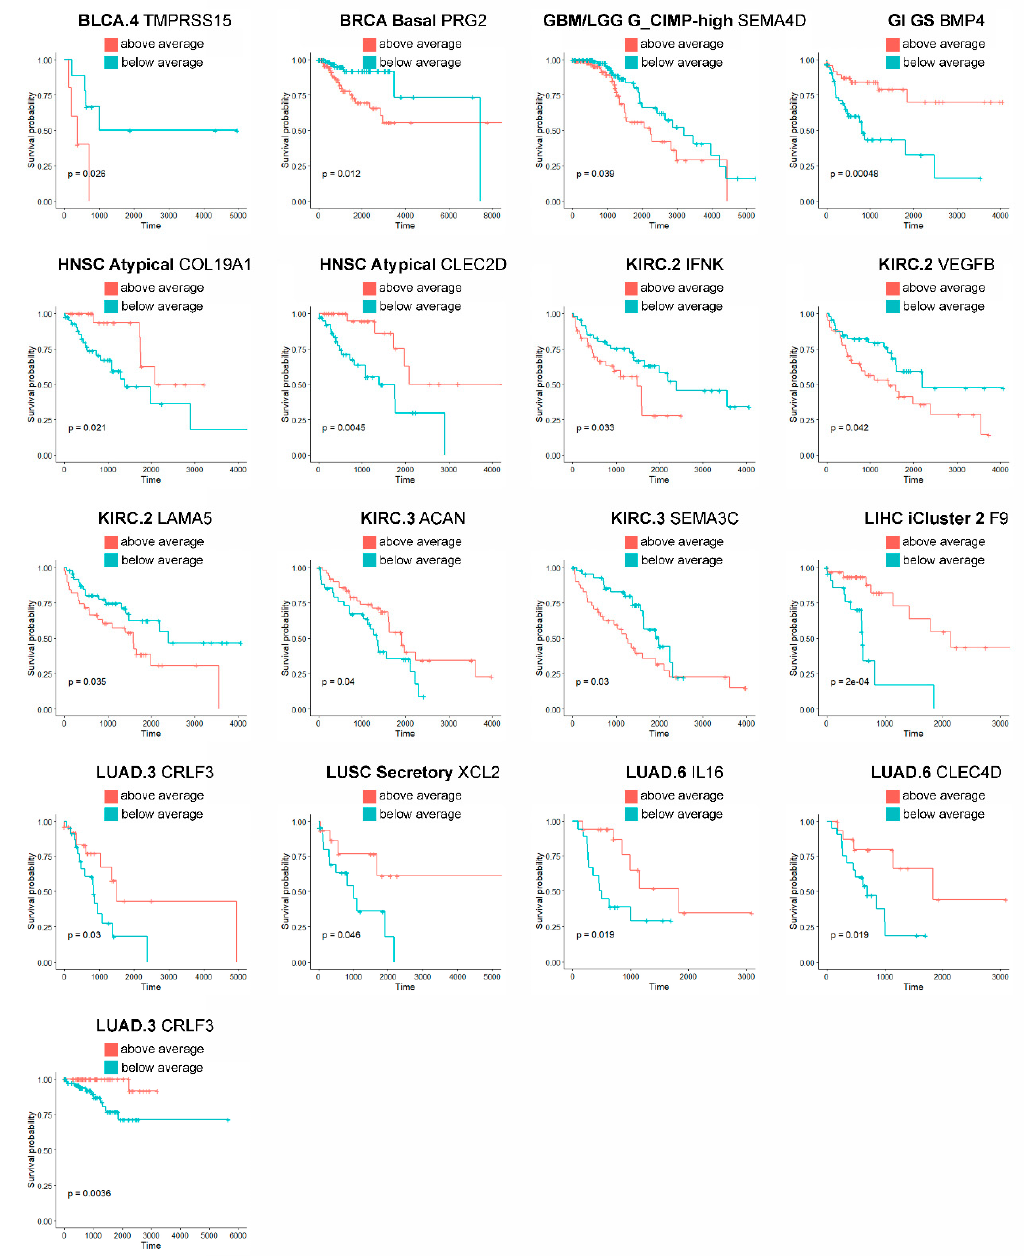
Figure 3. Prognostic landmark matrisome genes. Only age-independent prognostic genes ( p value < 0.05, COX-proportional hazard model adjusted for age) are reported.